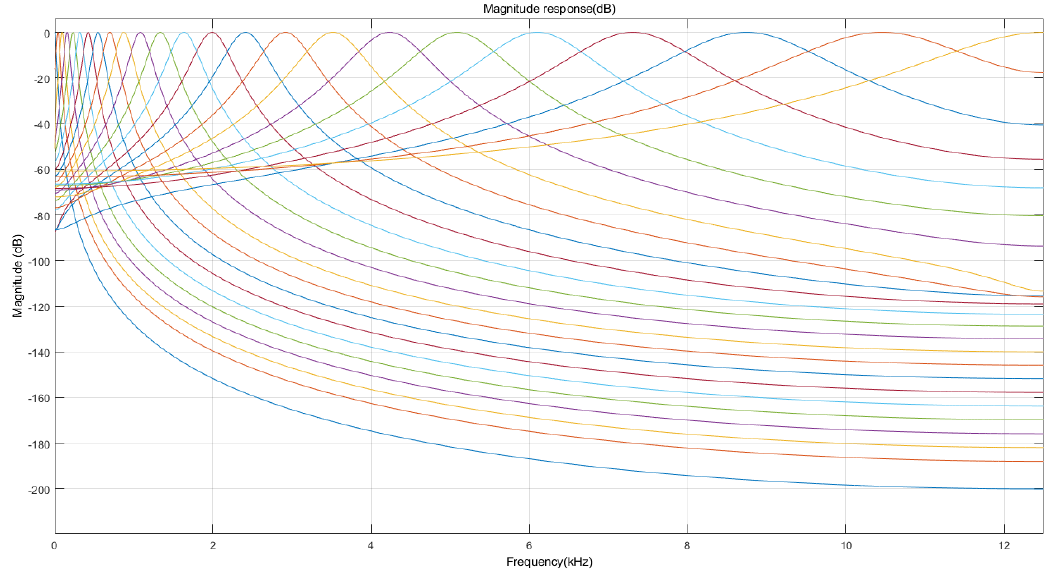
Figure 2. A 24-channel gammatone magnitude response.